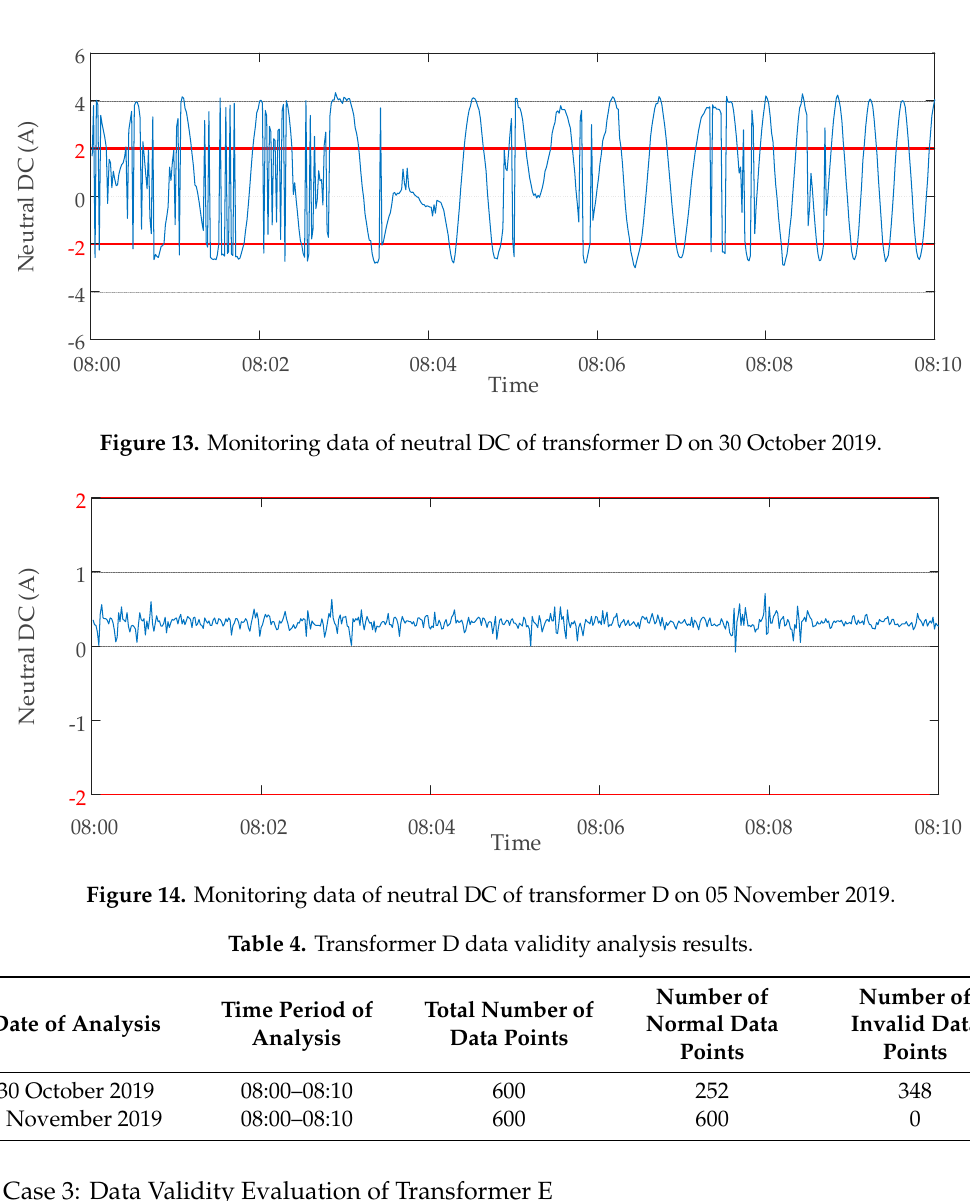
Time Figure 15. Monitoring data of noise intensity of transformer E on 18 October 2019.